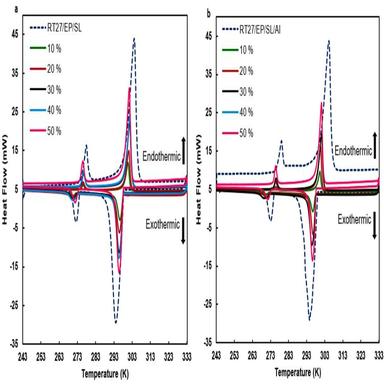
DSC curves of composites with different mass fractions without (a) and with (b) aluminum inserted in the plaster.